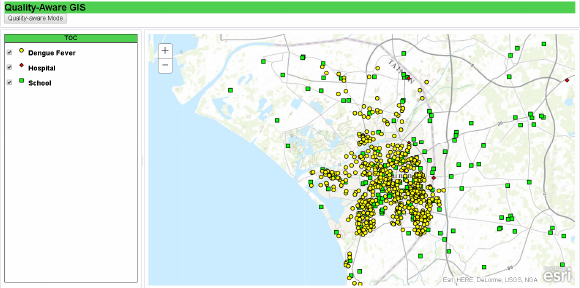
Figure 7. Traditional GIS interface